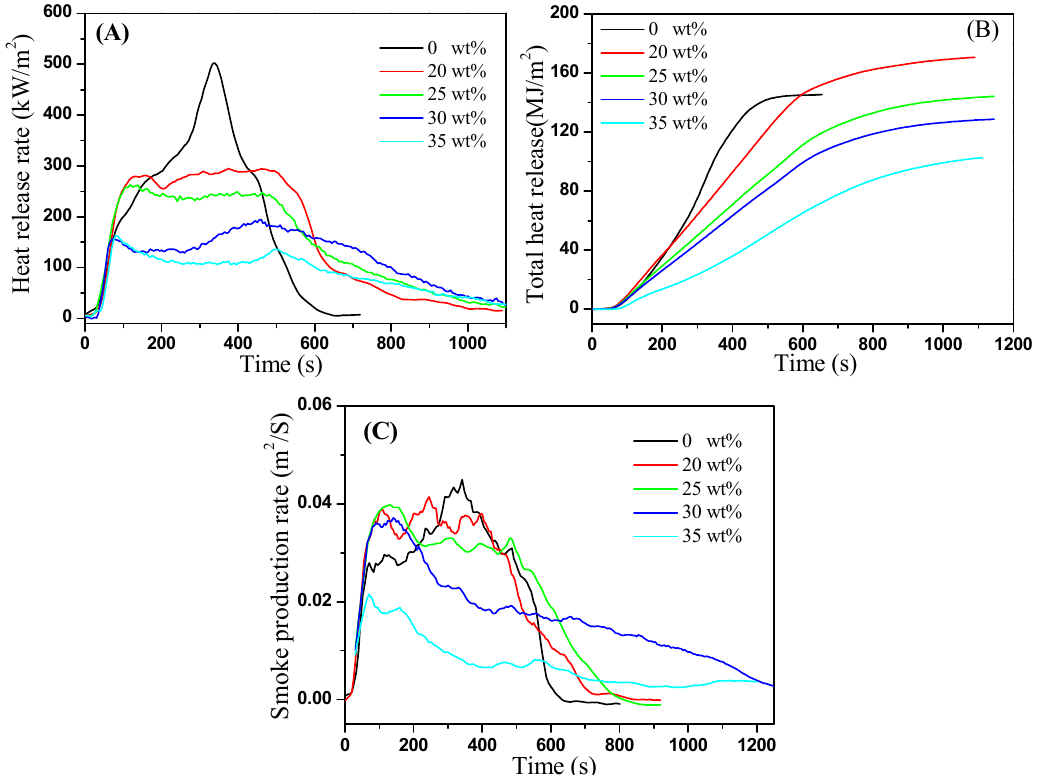
Figure 8. The heat release rate ( A ); Total heat release ( B ); and smoke production rate ( C ) of reactive extruded EPDM/PP/IFR composites with different content of IFR (MP/PER). Table 5. Cone calorimeter data of reactive flame retardant EPDM/PP/IFR composites with different IFR